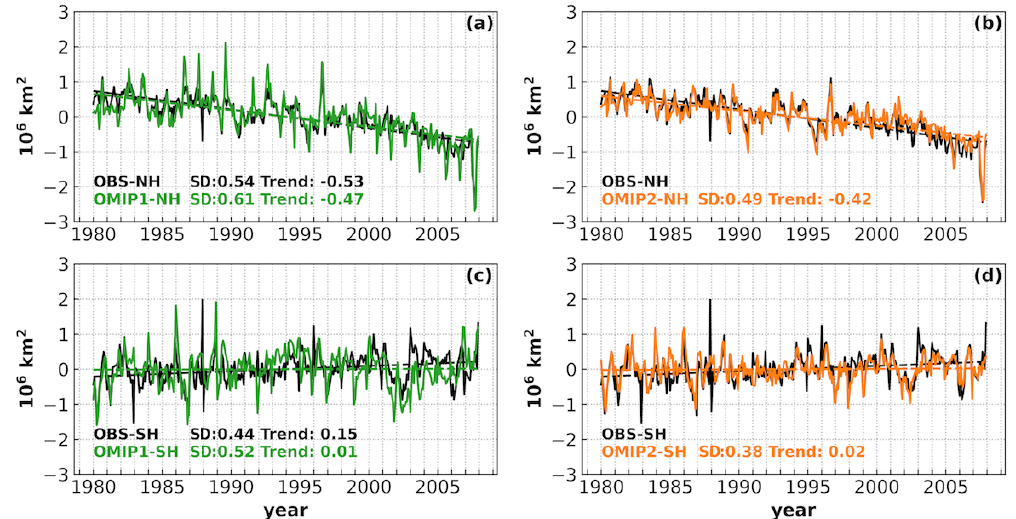
Figure 4. The 1980–2007 monthly anomalies of ice extent (10 6 km 2 ) from the observational mean of NSIDC-0051 and OSI-450 (solid black), five-model mean under OMIP1 or OMIP2 protocol (solid green vs. solid orange) in the Arctic (a, b) and Antarctic (c, d) . The five- model mean is from CMCC-CM2-SR5, EC-Earth3, MIROC6, MRI-ESM2-0, and NorESM2-LM. The dashed lines are the trends computed from linear regression over 1980–2007. The standard deviation (SD, 10 6 km 2 ) and trend (10 6 km 2 decade − 1 ) of the monthly anomalies of ice extent are computed and